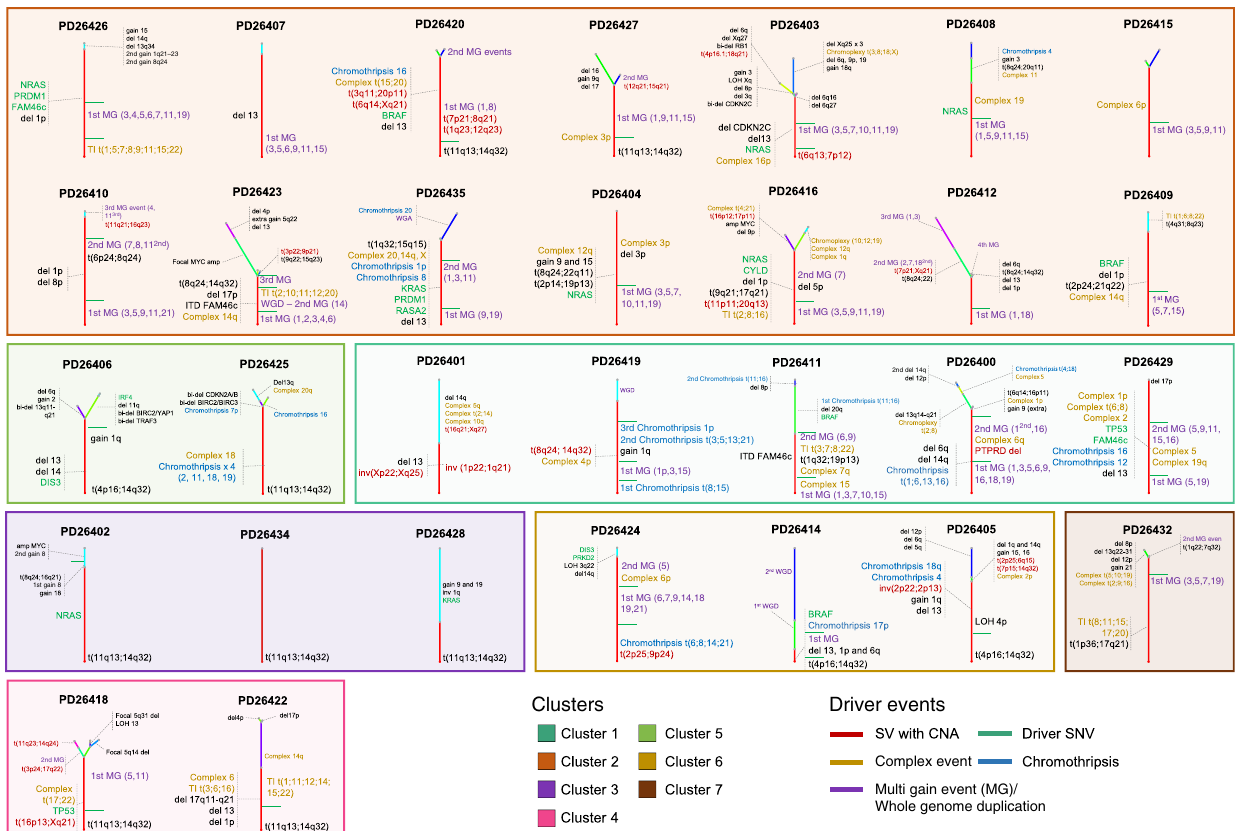
Fig. 6 The chronological reconstruction of driver events in MM. Phylogenetic trees generated from the Dirichlet process analysis ( “ Methods ” ). The root (always colored in red) and branch length are proportional to the (sub)clone mutational load. All main drivers (CNAs, SNVs, and SVs) were annotated according to their chronological occurrence. Early clonal events (root) were chronologically annotated on the right, when it was possible to establish a speci fi c time window. Here, all different root time windows were separated by a green line. Conversely, early drivers without a clear timing were grouped together on the left of the root. All driver events that occurred in the root were reported with larger font size. Patients were grouped according to the genomic clustering shown in Fig. 1c, and color-coded accordingly. TI = templated